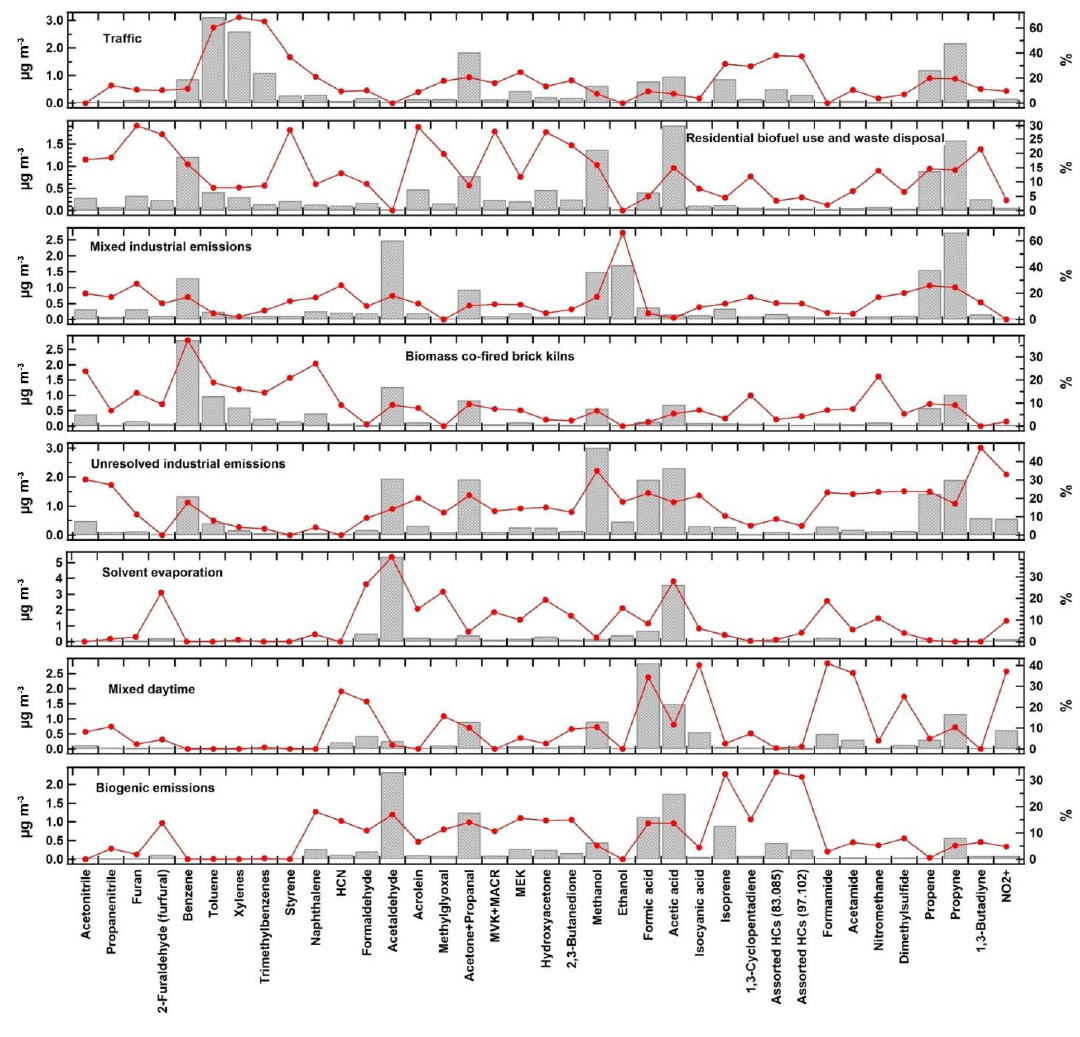
Figure 3. Factor profiles of the eight sources obtained by PMF analysis.